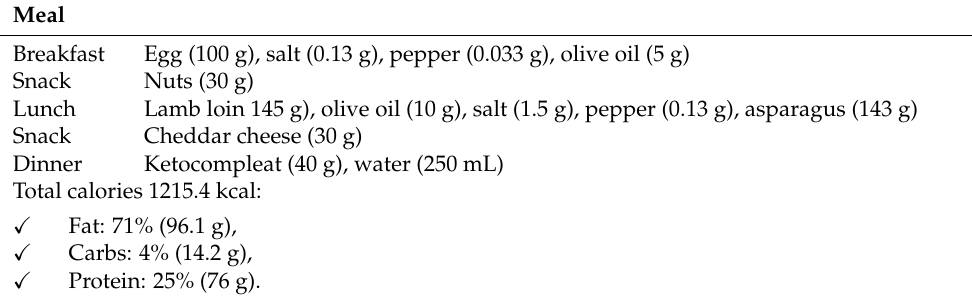
Table 3. An example of preoperative ketogenic diet daily plan used by Schiavo et al.